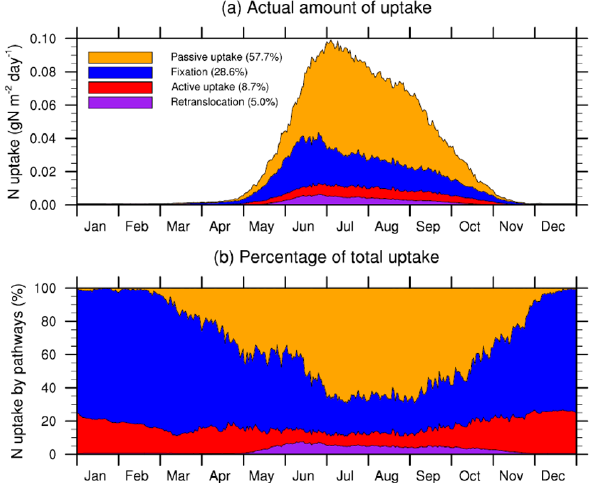
Figure 9. Daily climatology (1989–2013) of nitrogen uptake by pathways expresses as (a) actual amount of uptake and (b) percent- age of total uptake.